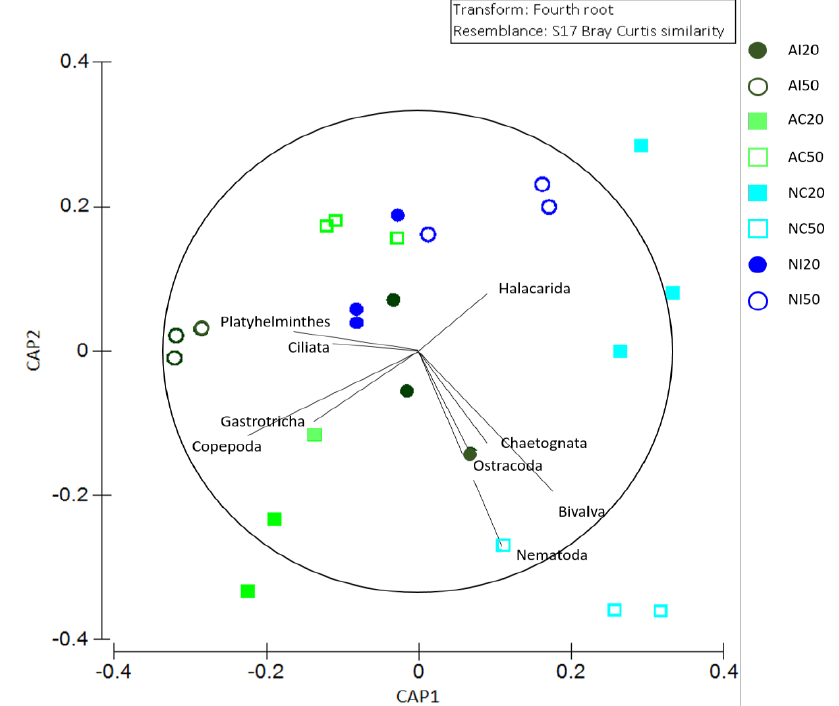
Figure 6. Canonical analysis of principal coordinates (CAP) of the interaction of Ar × De factors. Dataset on total taxa is correlated by the Pearson index ( ρ > 0.35). Straight lines are vectors of taxa, whose orientation and length are proportional to the most correlated plot elements. Circle represents 95% confidence interval. Table 3. Pair-wise comparisons and t-statistics for differences in rare meiobenthic assemblages among stations within levels of the depth factor. Significant tests relevant to the hypothesis are given in